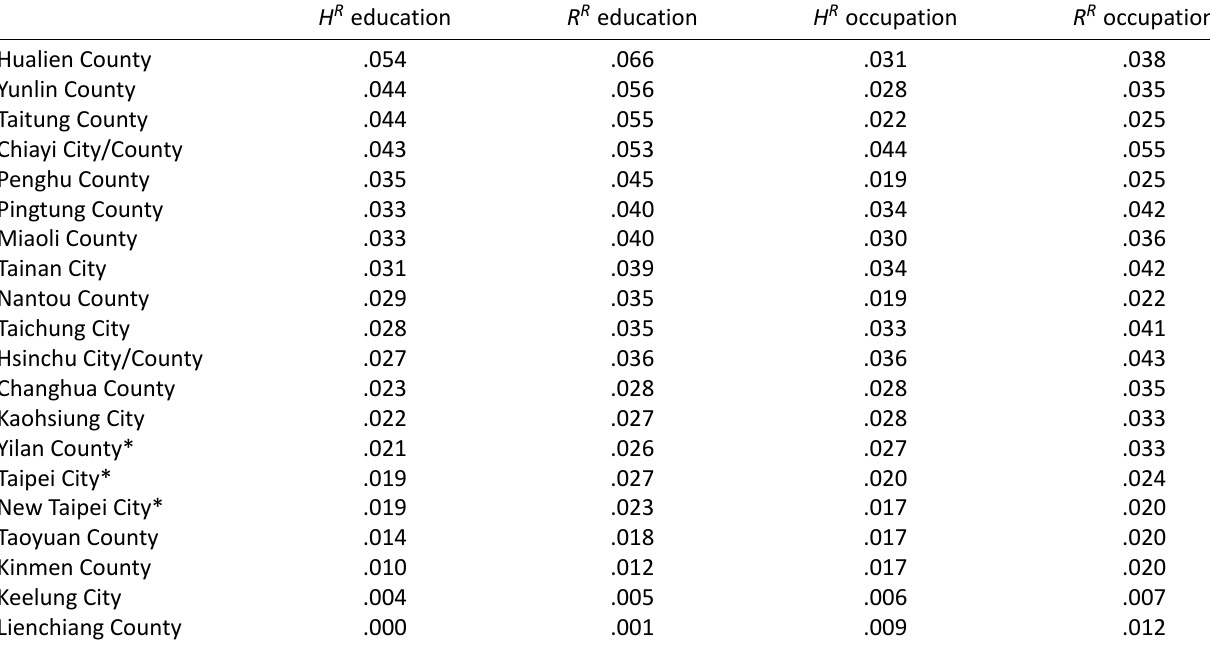
Table 1. Residential segregation by education and occupation in counties and